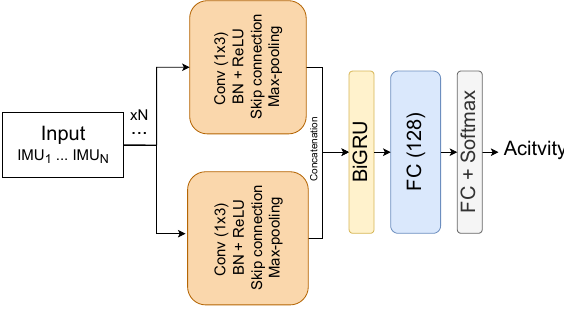
Figure 3. The proposed ResRNN model for feature